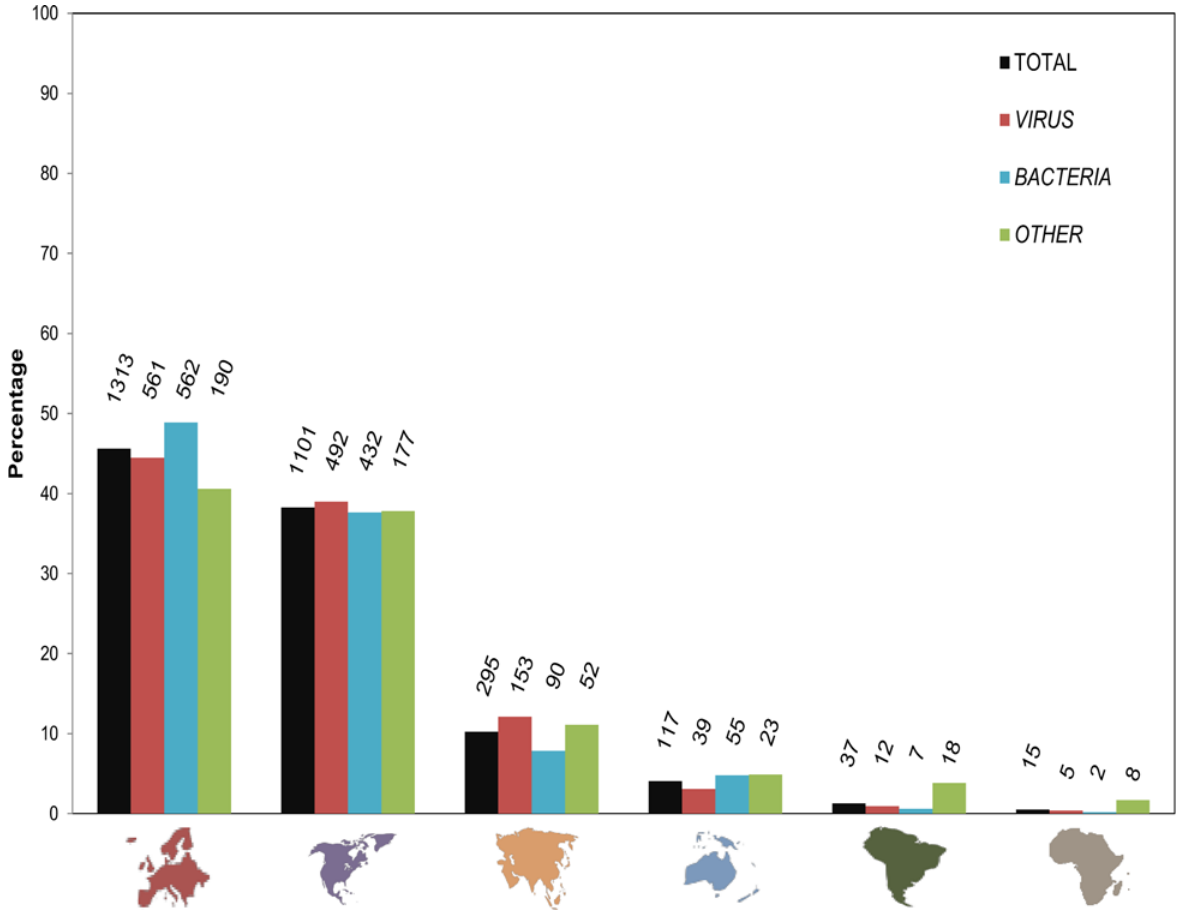
Fig 4. Distribution by continents (percentage) of papers included in the H-index scores. Bars show percentage of origin of the first author affiliation for the papers included in the H-indices; total papers (n = 2,878) (black), Virus ’ papers (n = 1,262) (red), Bacteria ’ s papers (n = 1,148) (blue) and O ther ’ s papers (n = 468) (green). Above each bar, absolute numbers of